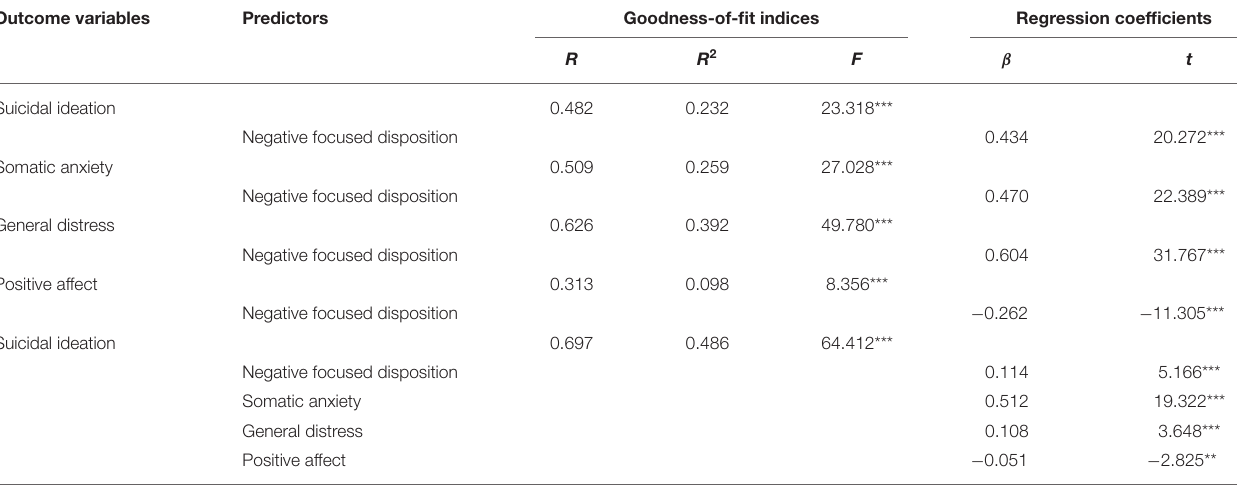
TABLE 3 | Regression coefficients between negative focused disposition, positive affect, somatic anxiety, general distress and suicidal ideation.